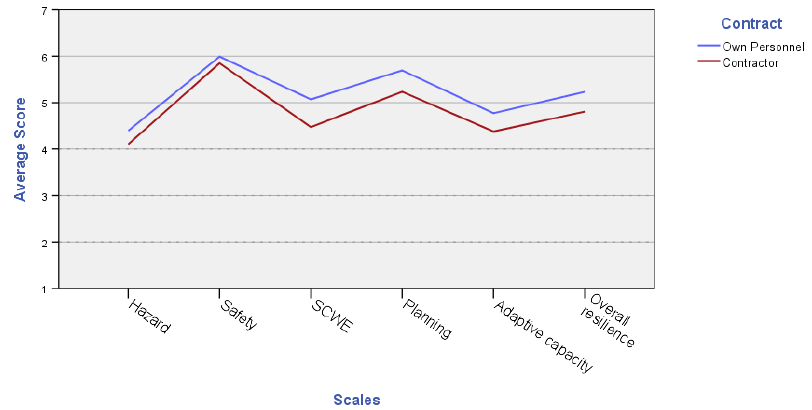
Figure 14. Scales averages by contract. BARS results are not homogeneous when it comes to contractual. On the one hand, some differences are statistically significant and have magnitudes with a small effect in